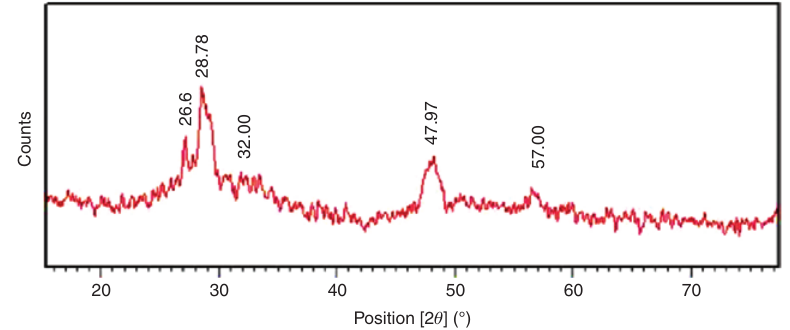
Figure 2: XRD pattern of the as-synthesized powder.